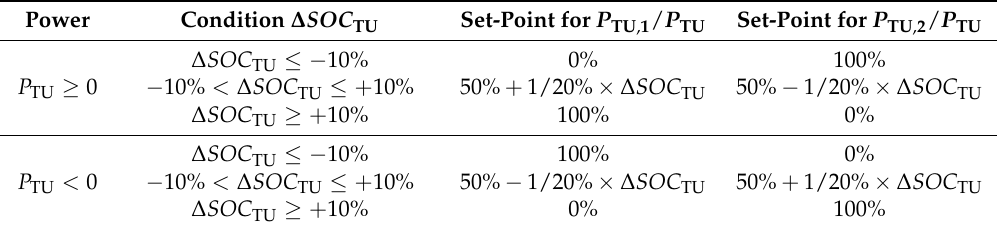
Table 3. State of Charge droop control for operation with both power strings active.